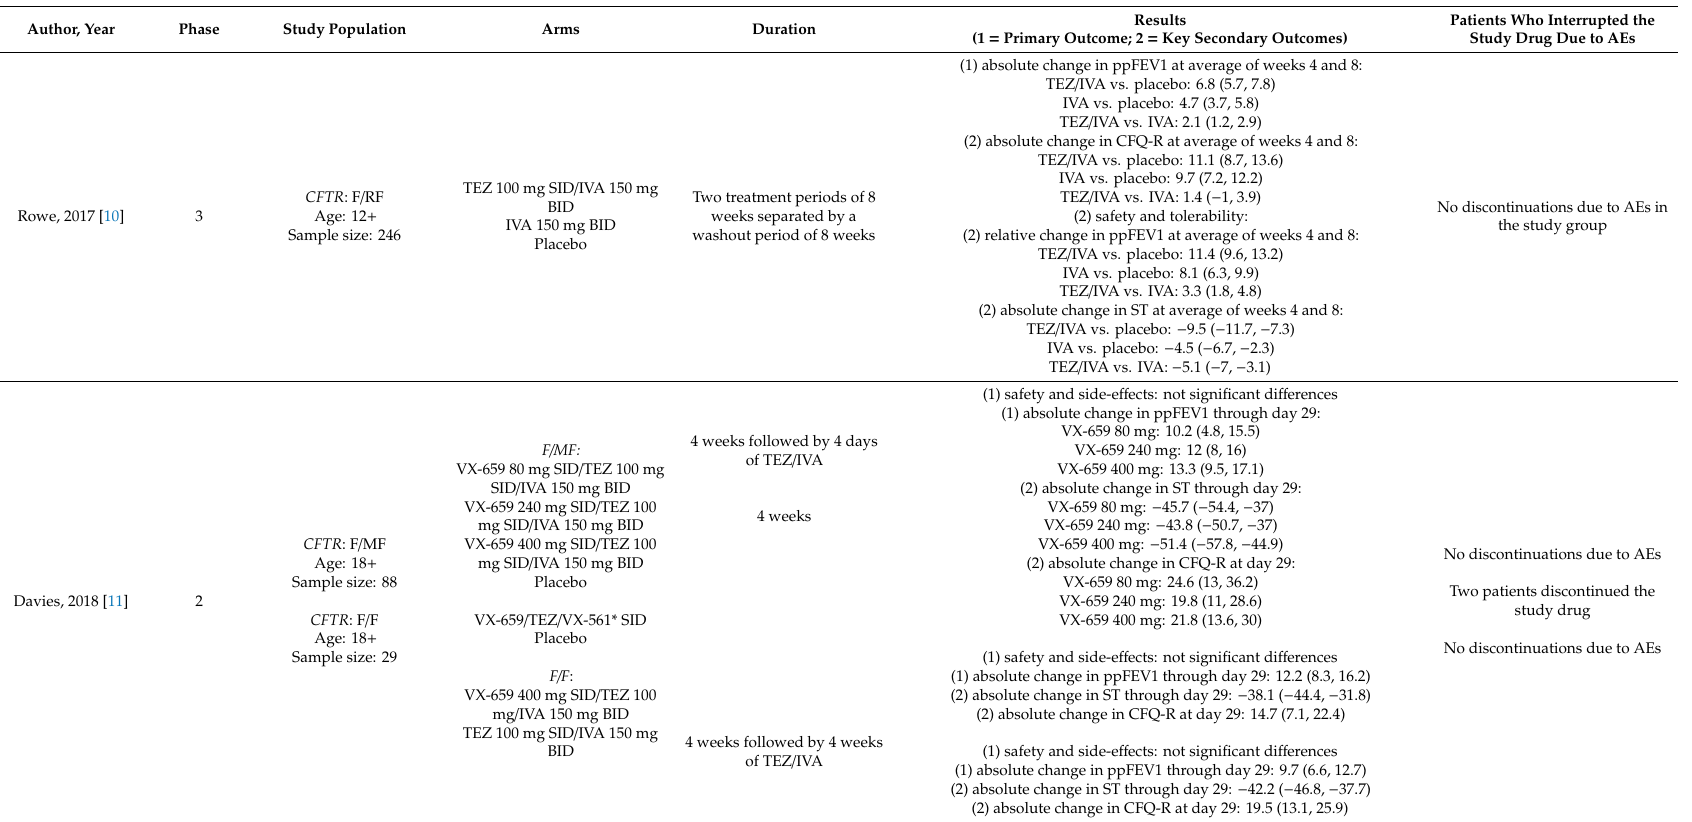
IVA vs. placebo: 9.7 (7.2, 12.2) TEZ / IVA vs. IVA: 1.4 ( − 1, 3.9)